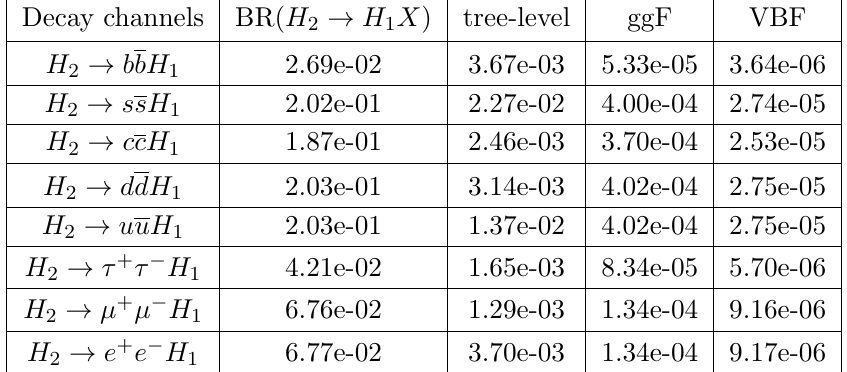
BR and cross section (in pb units) for di(cid:11)erent processes for m DM = 54 GeV in scenario I10.